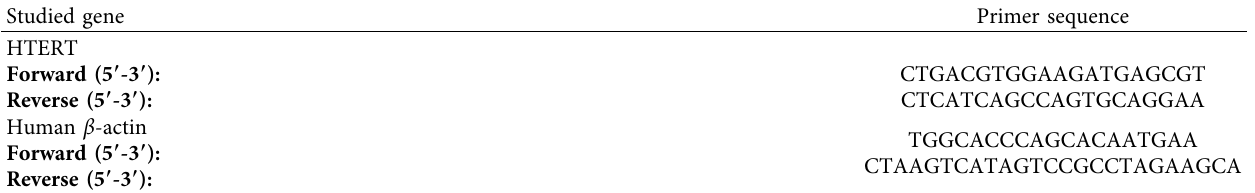
Table 1: Sequences of forward and reverse